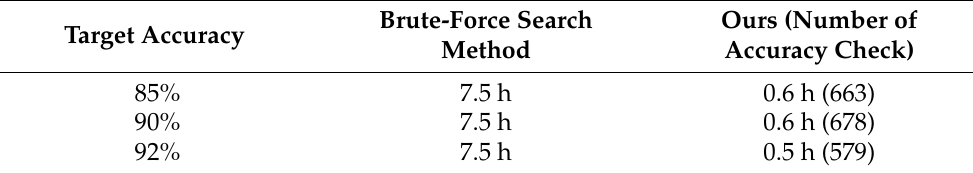
Table 9. The execution times in the corresponding accuracies derived from the proposed method and the individual cases of network slimming and deep compression for DenseNet-40.